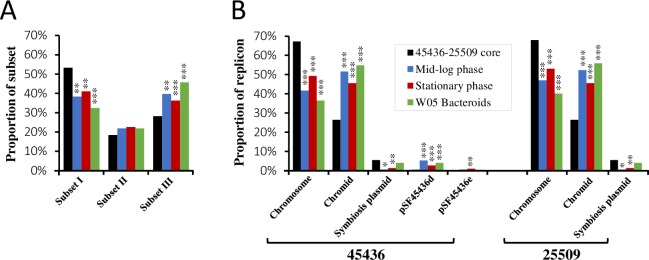
Replicon-dependent transcriptional variations between CCBAU45436 and CCBAU25509 under free-living and symbiotic conditions.(A) Enrichment analyses of differentially expressed genes (Log2R > 1.732, FDR < 0.001) between CCBAU45436 and CCBAU25509 under free-living and symbiotic conditions for the hierarchical core/accessory subsets. (B) Enrichment analyses of differentially expressed genes between CCBAU45436 and CCBAU25509 under free-living and symbiotic conditions for each replicon. The black bars represent the background ratios of 45436–25509 shared genes in each of the hierarchical core/accessory subsets or replicons. Significant enrichment and/or depletion are indicated by stars (*, P < 0.05; **, P < 0.01; ***, P < 0.001; Pearson’s chi-square test). All analyses of this figure are based on datasets without multi-copy genes and strain-specific genes.